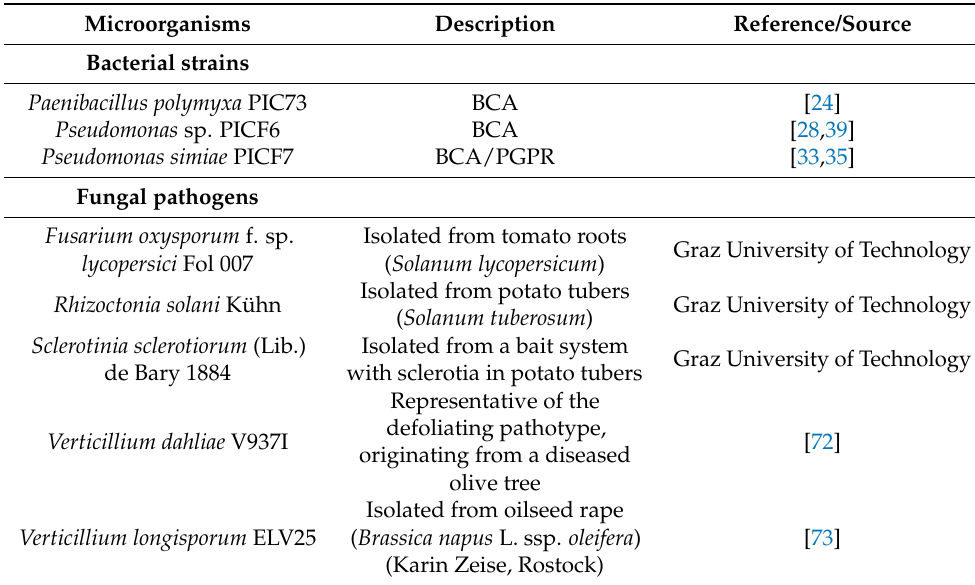
Table 4. Bacteria and fungi used in this